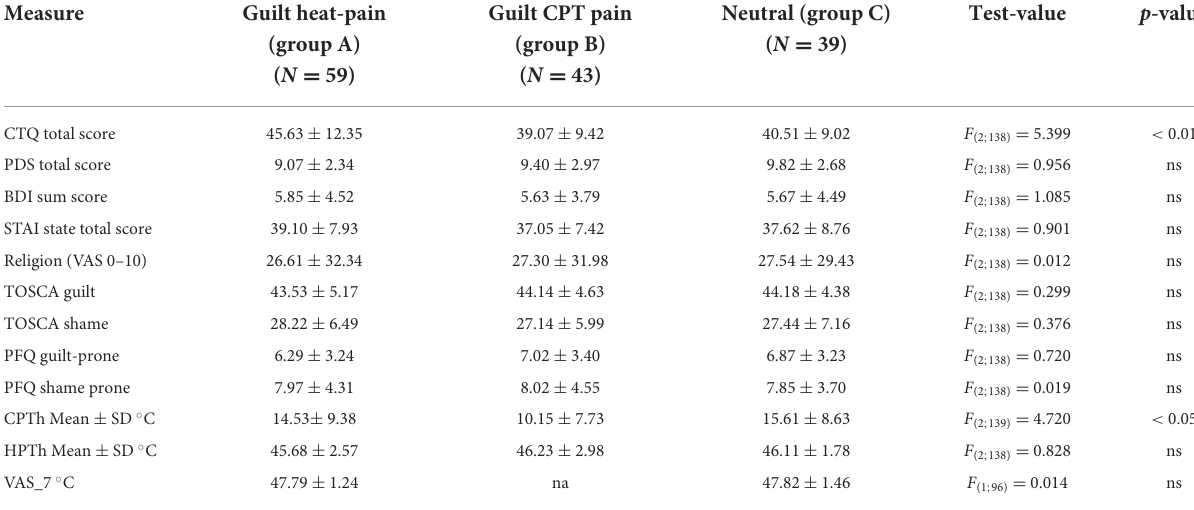
TABLE 2 Questionnaires and QST